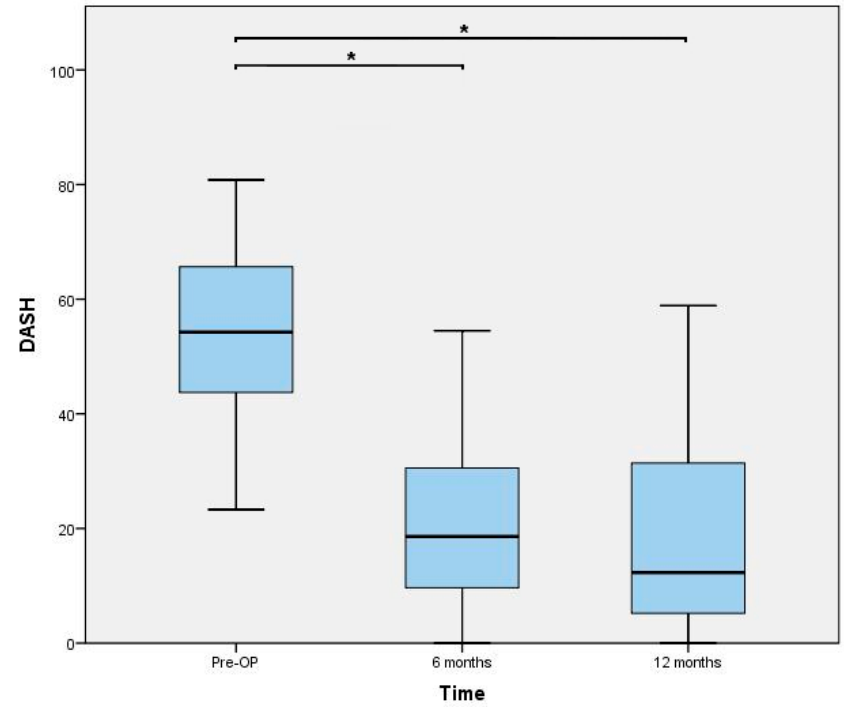
Figure 3. Disabilities of the Arm, Shoulder and Hand (DASH) score outcomes. * indicating a p -value < 0.0001.